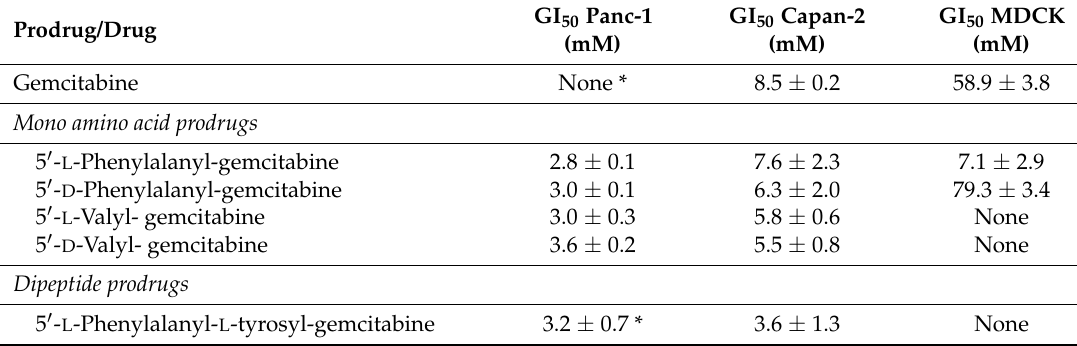
Table 7. Cell growth inhibition in Panc-1, Capan-2, and MDCK cells (mean ± S.D., n =